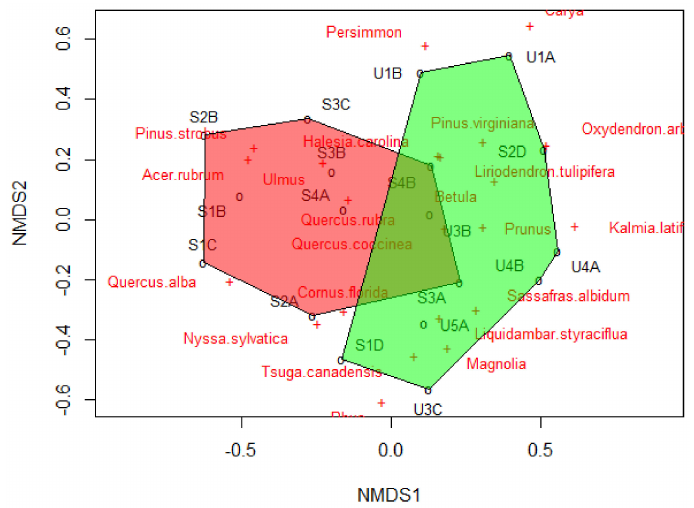
Figure 5. Non-metric multidimensional scaling (nMDS) of saplings in plots after tornado and salvage logging. Salvaged plots are indicated in red , and unsalvaged plots are green